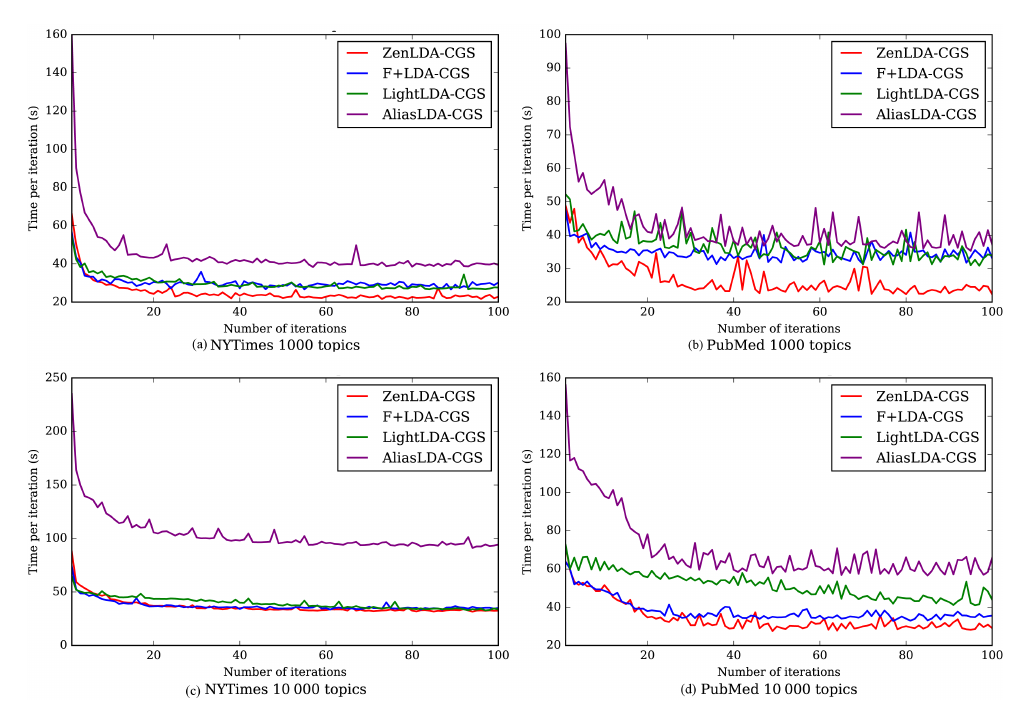
Fig. 5 Comparison among different CGS algorithms: time-iteration